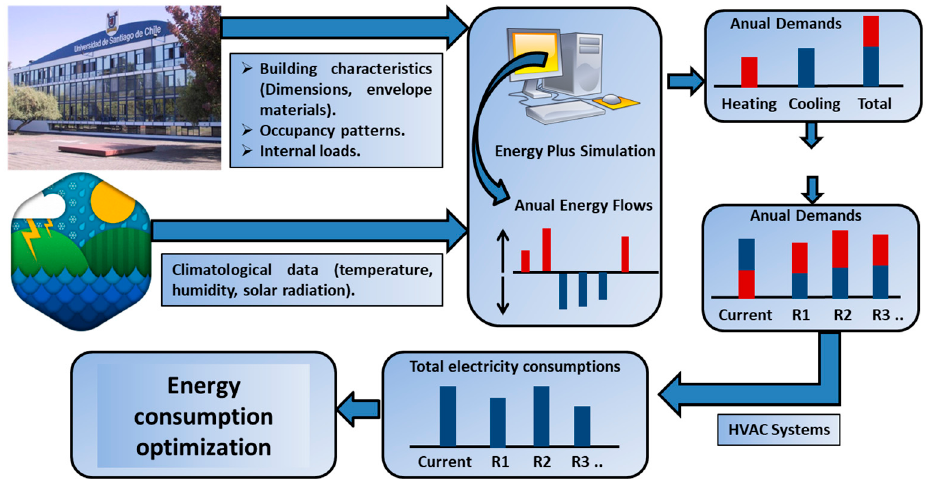
Figure 5. Graphical description of the methodology.